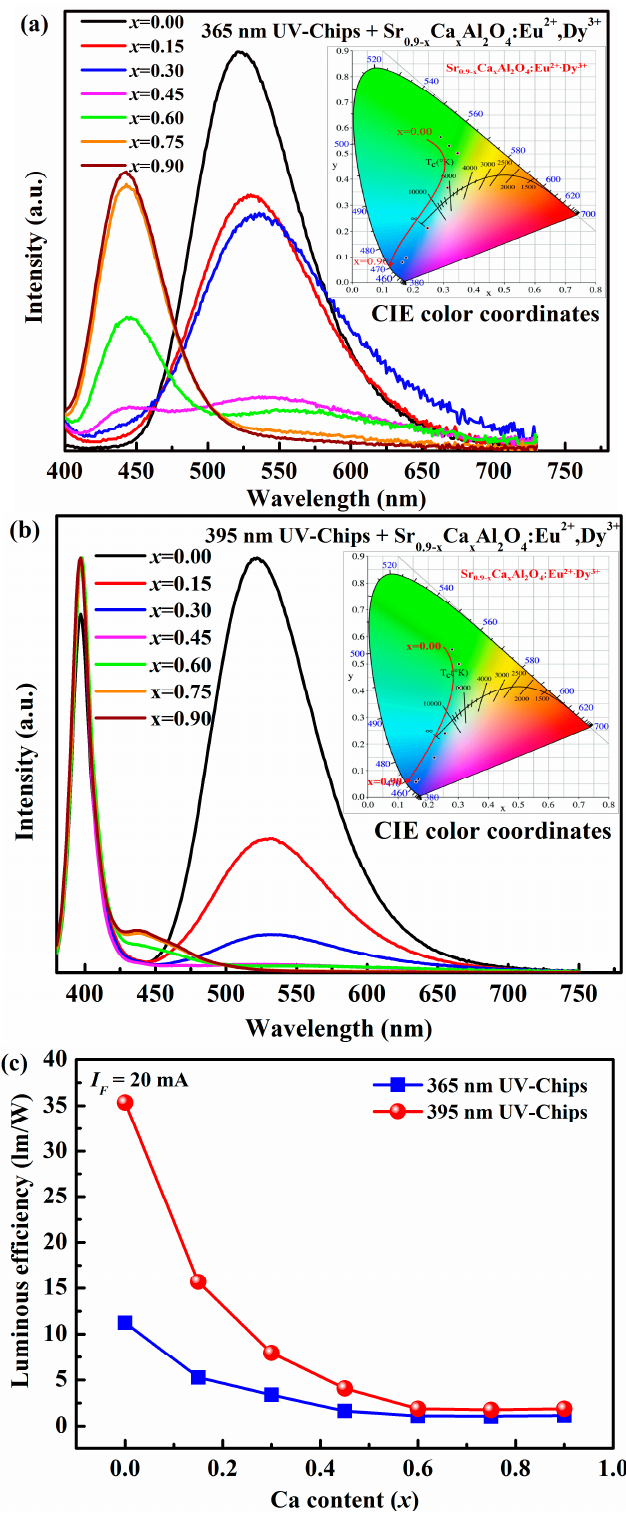
Figure 5. Electroluminescence spectra of the as-fabricated LEDs based on UV chip and Sr 0.90 − x Ca x Al 2 O 4 :0.05Eu 2+ , 0.05Dy 3+ phosphors under 20 mA forward-bias current (i.e., I F = 20 mA). Inset is chromaticity diagram of the as-fabricated LEDs: ( a ) 365 nm UV chip; ( b ) 395 nm UV-chip; ( c ) Luminous efficiency of as-fabricated LEDs with different Ca 2+ content under I F = 20 mA.